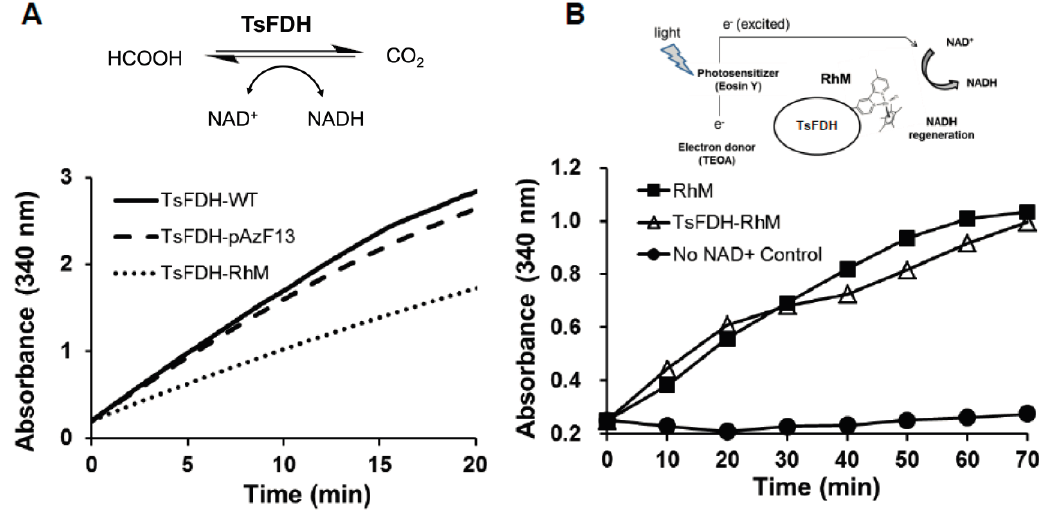
Figure 5. Characterization of TsFDH-RhM. ( A ) NAD + -dependent conversion of formate to carbon dioxide by TsFDH-RhM (40 nM), TsFDH-V13pAzF (40 nM), TsFDH-WT (40 nM), and RhM (40 nM); ( B ) Photo-induced generation of NADH. The reaction mixture consisting of TEOA (5%), eosin Y (20 µM), NAD + (0.8 mM), and TsFDH-RhM (40 μ M) or free RhM (40 μ M) was illuminated by white light at 37